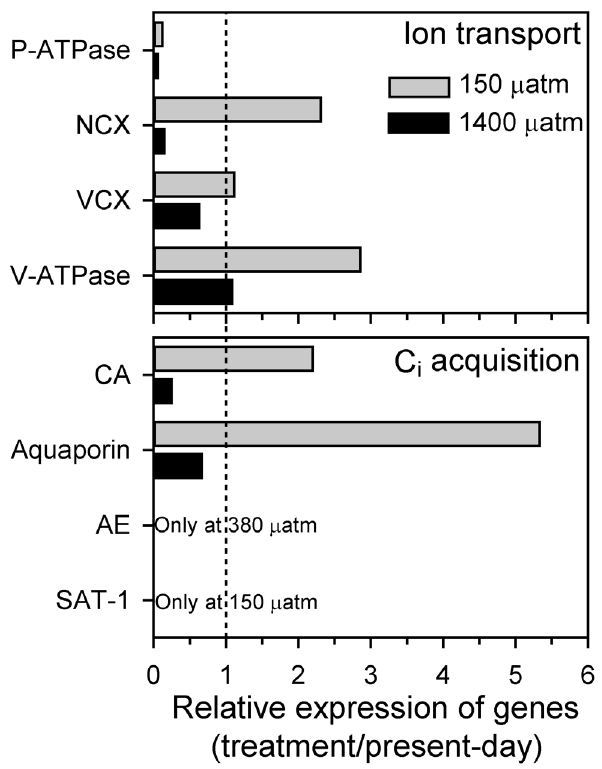
Figure 4. Effect of elevated p CO 2 on gene regulation. Number of readings found for genes associated to ion transport and C i acquisition in the 150 m atm and 1400 m atm CO 2 treatments relative to the present- day (380 m atm) CO 2 treatment.